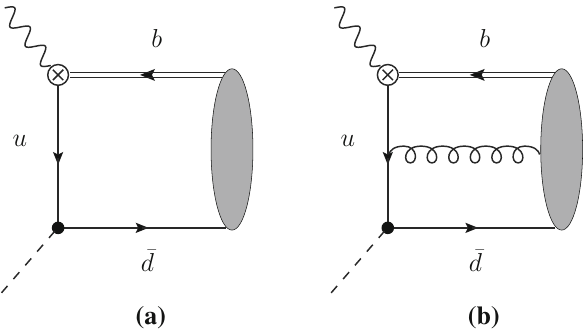
Fig. 2 Diagrams for the calculation of the quark–gluon contribution to the two and three-body B meson LCDAs. The circle cross denotes the V − A current while the black dot denotes the interpolating current for the πη state. The gray bubbles represent two- or three-particle LCDAs of the B